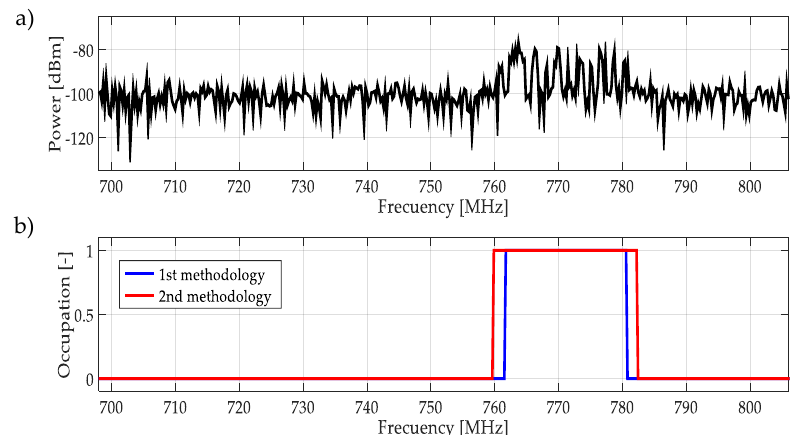
Figure 21. ( a ) A real signal obtained from the frequency band [698 – 806] MHz. ( b ) The result of applying both methodologies to the real signal in terms of spectrum occupancy. In this case, the second methodology gives a better frequency edge detection.